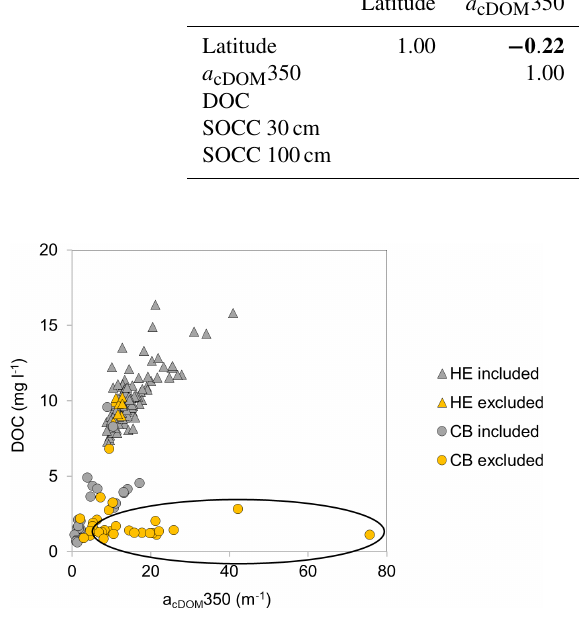
Figure 7. Relationship between coloured dissolved organic matter absorption a cDOM 350 (m − 1 ) and dissolved organic matter concen- tration DOC (mgL − 1 ) at Herschel Island (HE) displayed as triangle and Cape Bounty (CB) shown as circle. Samples marked in orange were excluded from the study due to flocculation after filtration (Sect. 3.1). The samples circled in black show disproportionately high absorption values in relation to the DOC